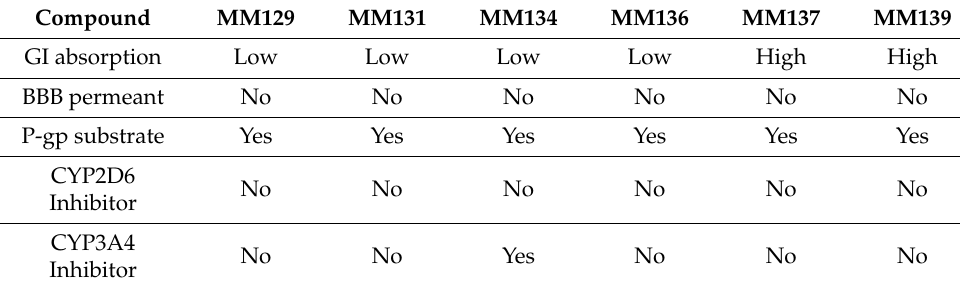
Table 6. Predicted ADMET properties of tested